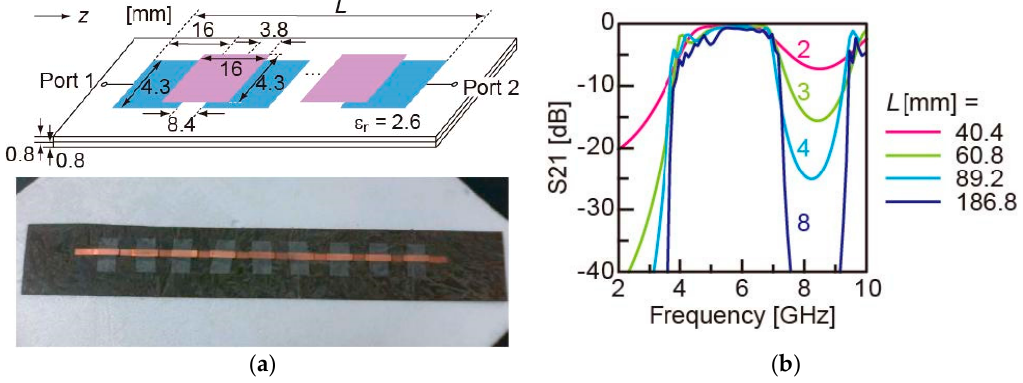
Figure 2. Sheet-like one-dimensional transmission line. ( a ) Waveguide structure, ( b ) Transmission characteristics of the waveguide.